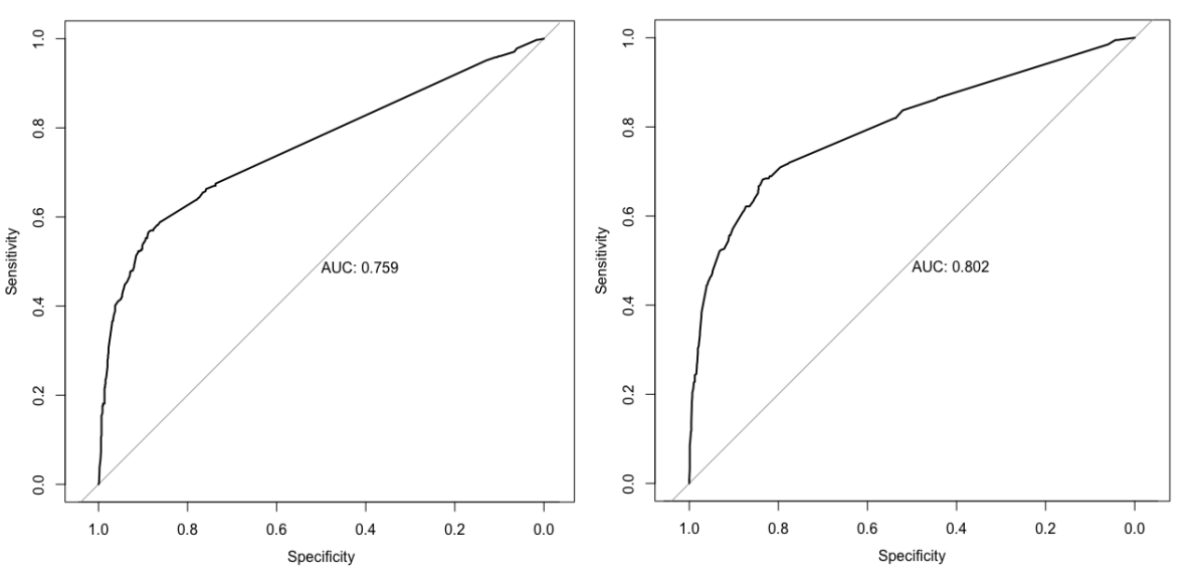
P valueT valueSEEstimateVariable